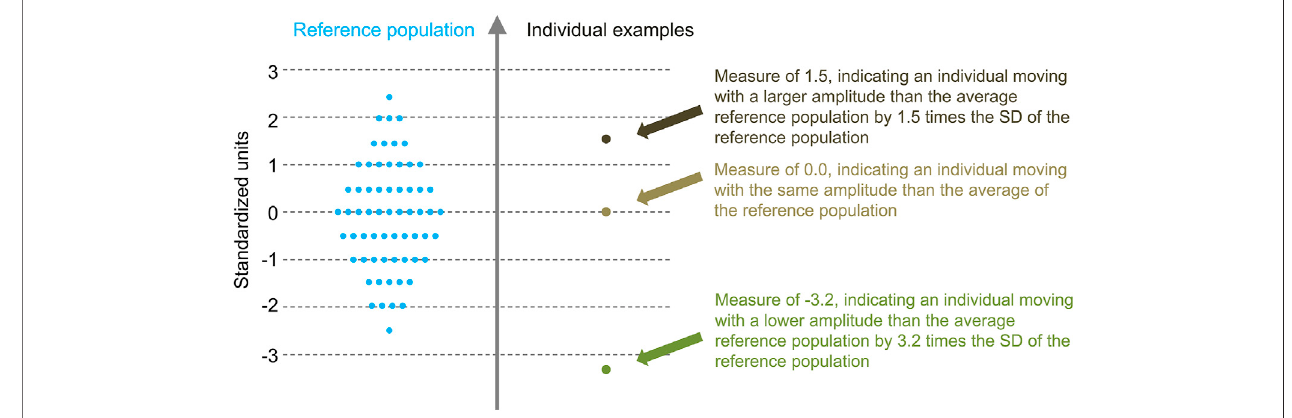
FIGURE 1 | Illustration of the task-independent measures concept. Task-independent measures are expressed according to the mean and SD of the reference population. These dimensionless measures therefore indicate how they situate compared to the reference population.